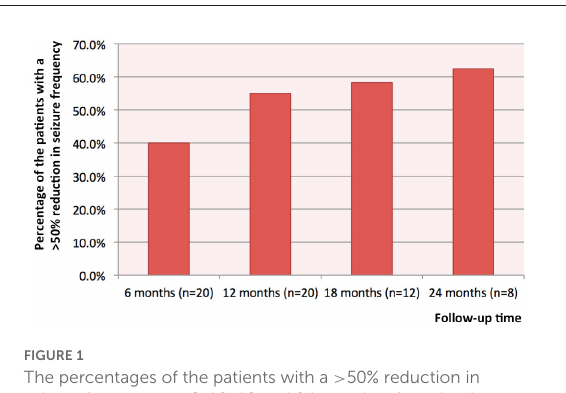
FIGURE1 The percentages of the patients with a > 50% reduction in seizure frequency at 6, 12, 18 and 24 months after stimulator implantation.